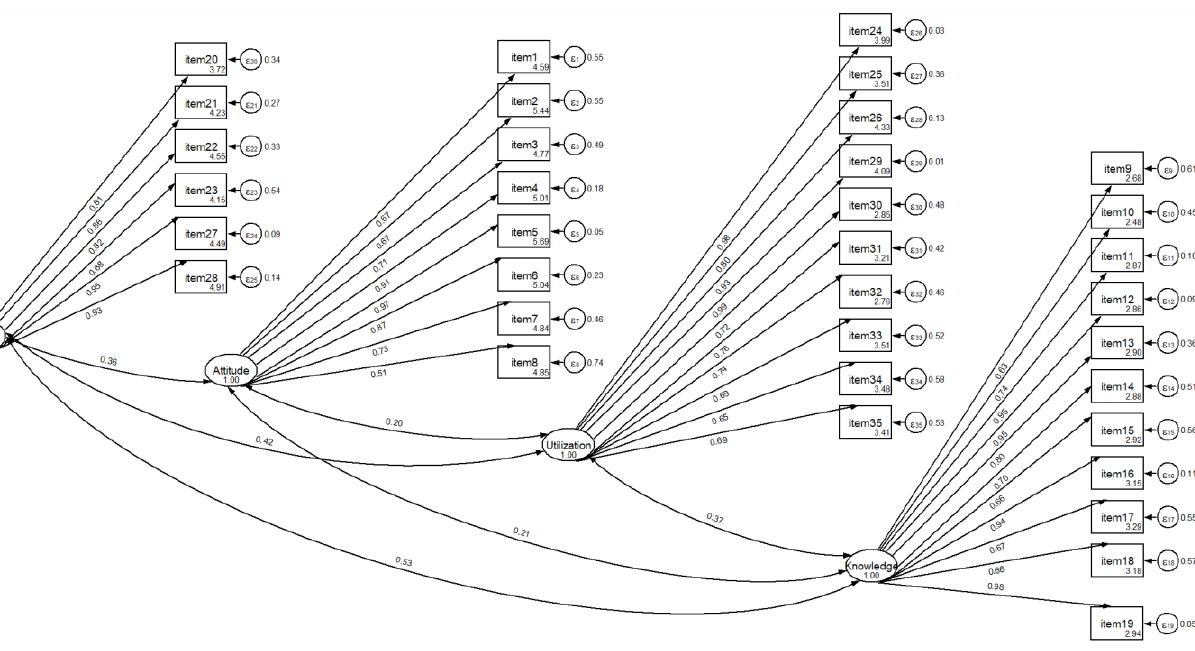
Figure 2. Scree plot. The four-factor solution derived in our study consisted of 35 items (Table 2). The Bartlett’s test of sphericity and the Kaiser–Meyer–Olkin index (KMO) were computed. The Bartlett’s test was significant [χ 2 (595) = 16,483.308, p < 0.001], and the KMO index was 0.906; therefore, the data were judged to be appropriate for factor analysis. The four-factor solution had: (1) zero items with salient loadings (≥0.50) on more than one factor; (2) zero items with no salient loading on any factor; and (3) well-defined salient loading per factor